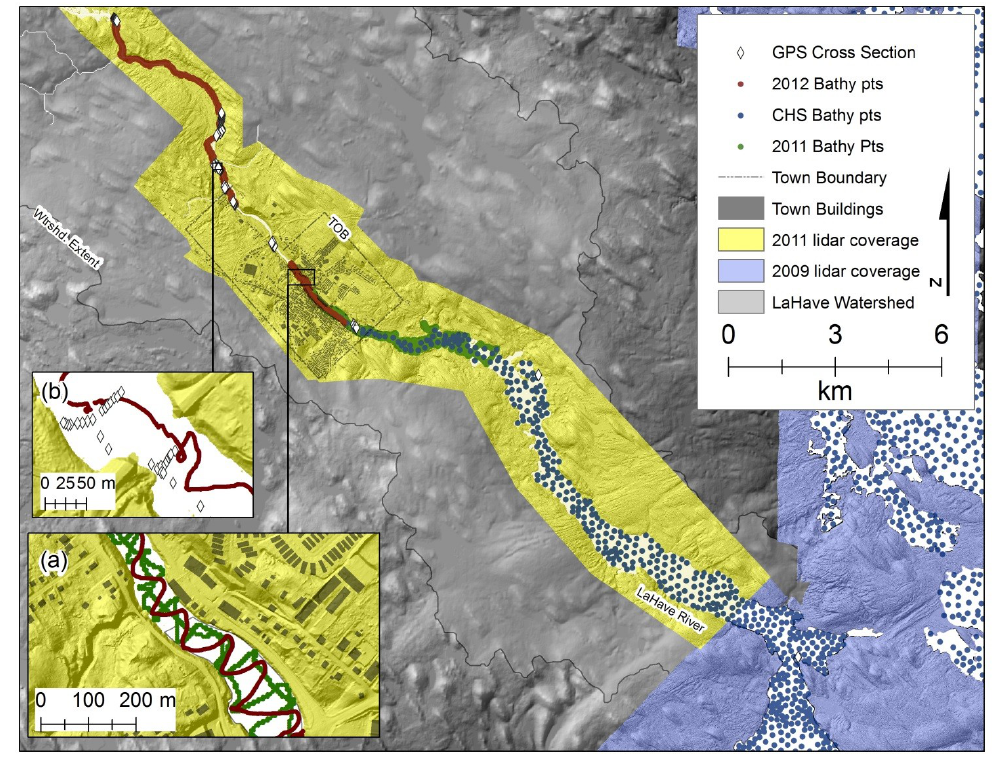
Figure 2. Topobathymetric data sets amalgamated in this study include high precision airborne lidar, Canadian Hydrographic Service (CHS) bathymetric charts, and bathymetric data collected by boat using depth sounder ( a ) and survey grade Real Time Kinematic (RTK) GPS ( b ). The extent of this figure is shown on Figure 1 as Area